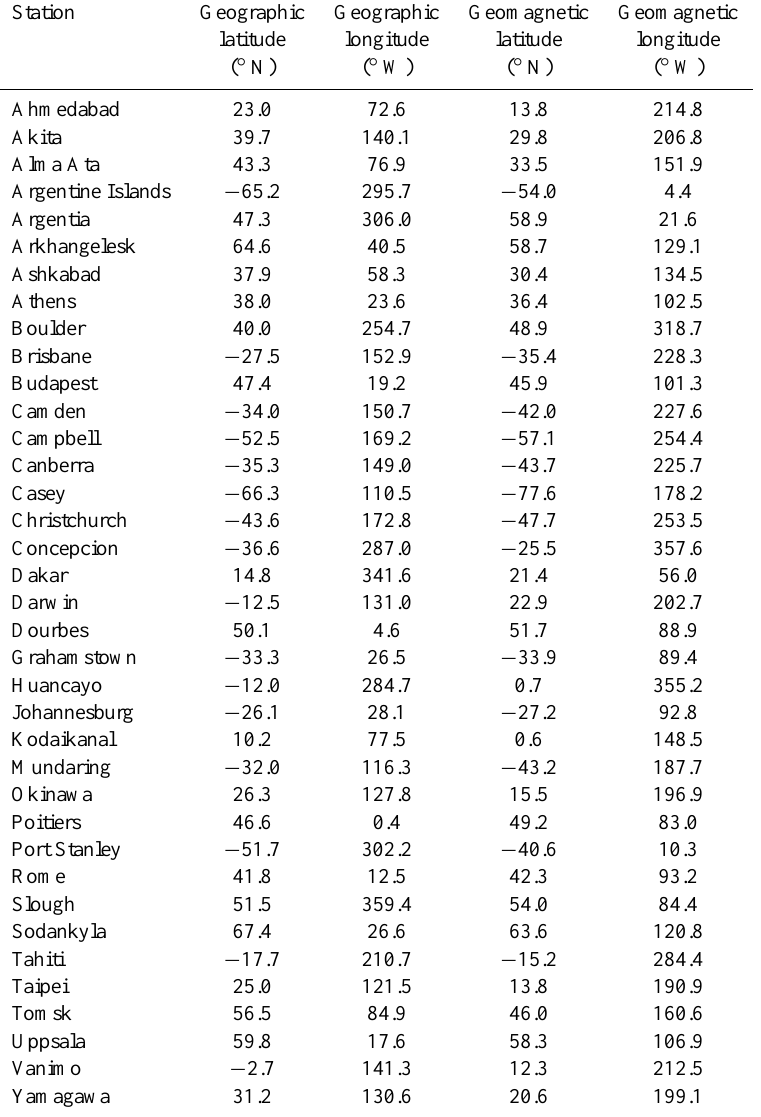
Table 1. Ionospheric stations analyzed in the present work (World Data Center for Solar Terrestrial Physics, WDC1 in England, Data